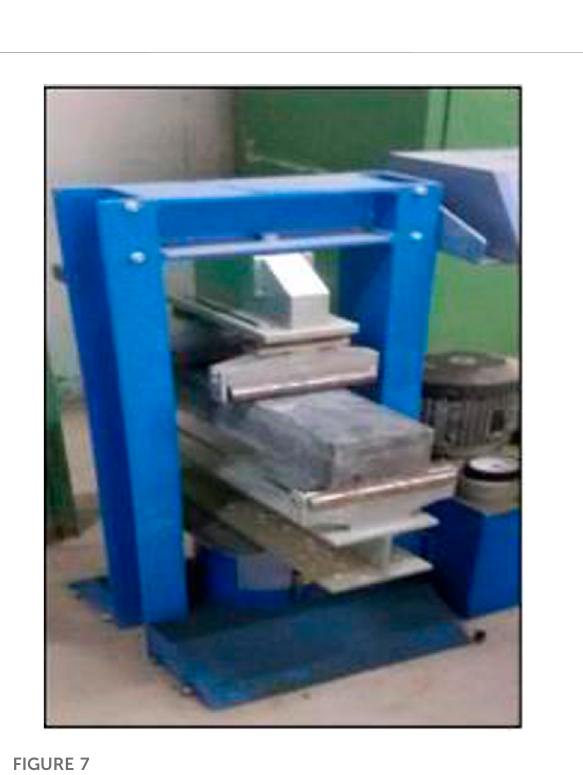
A sample of the tensile splitting test.